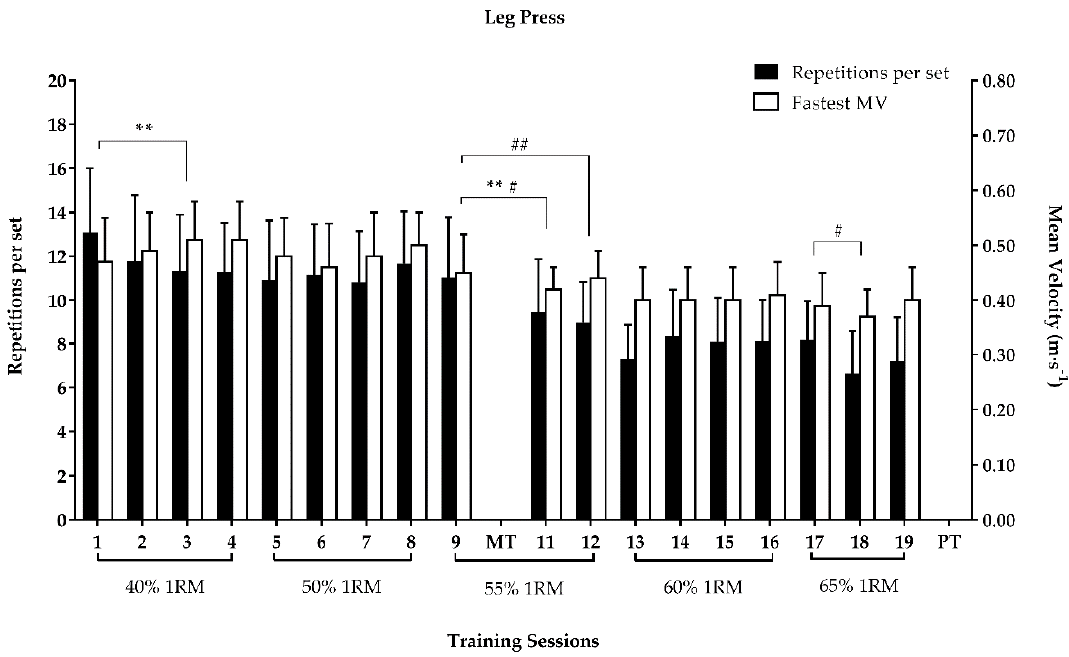
± SD) in the leg-press exercise throughout the